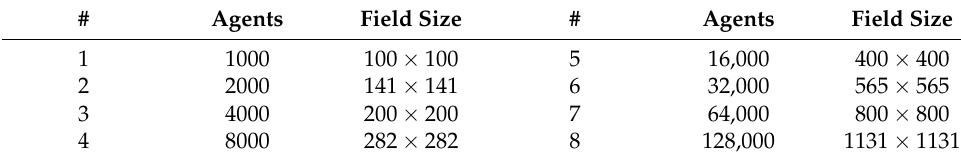
Table 8. Experiment configurations for evaluating ABM tools’